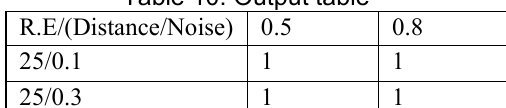
Table 9. Fuzzy relation R.E AND (Distance /Noise). Table 10. Output table